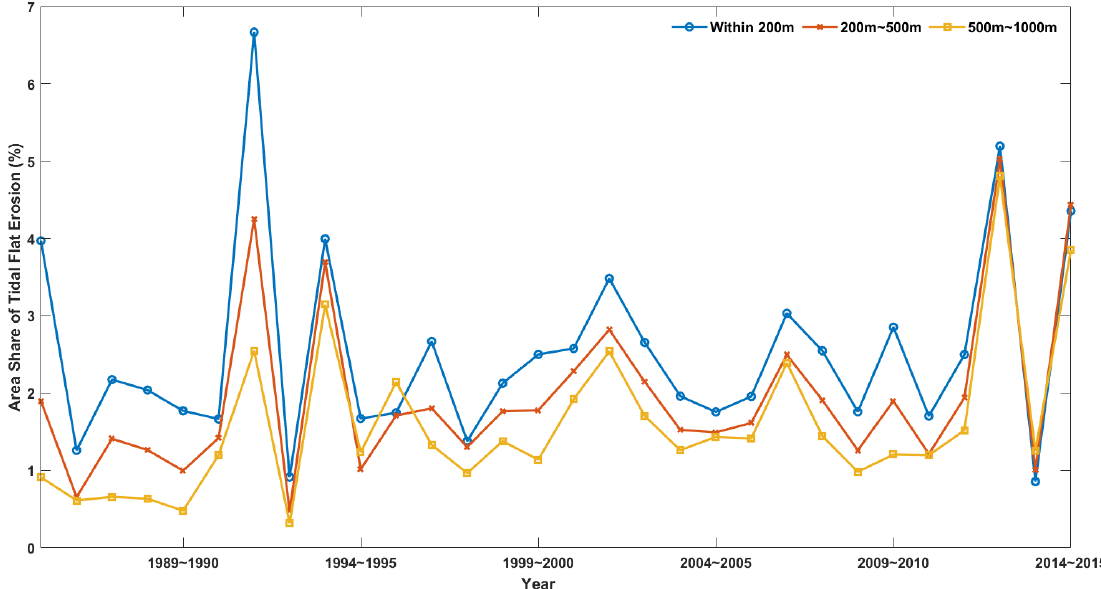
Figure 10. The intensity of tidal flat erosion around the seaward-expanded urbans.